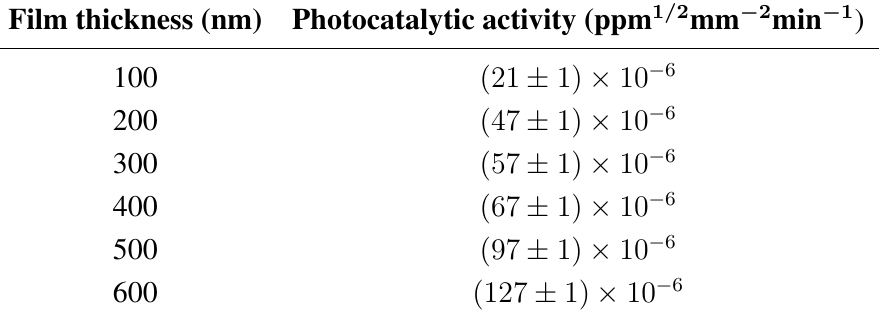
Table 3. Photocatalytic activity at various film